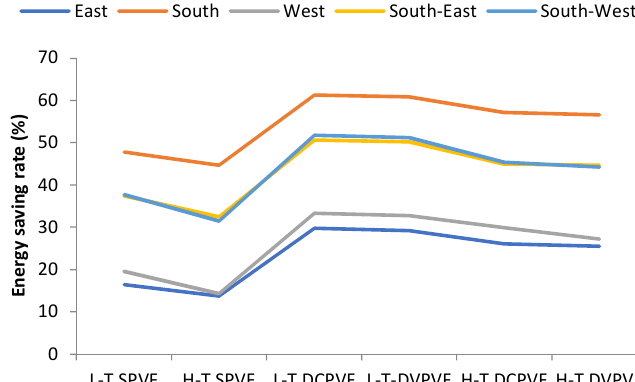
Figure 8. Energy saving rates of Photovoltaic façade (PVF) at different orientations in China cold- zone [48].